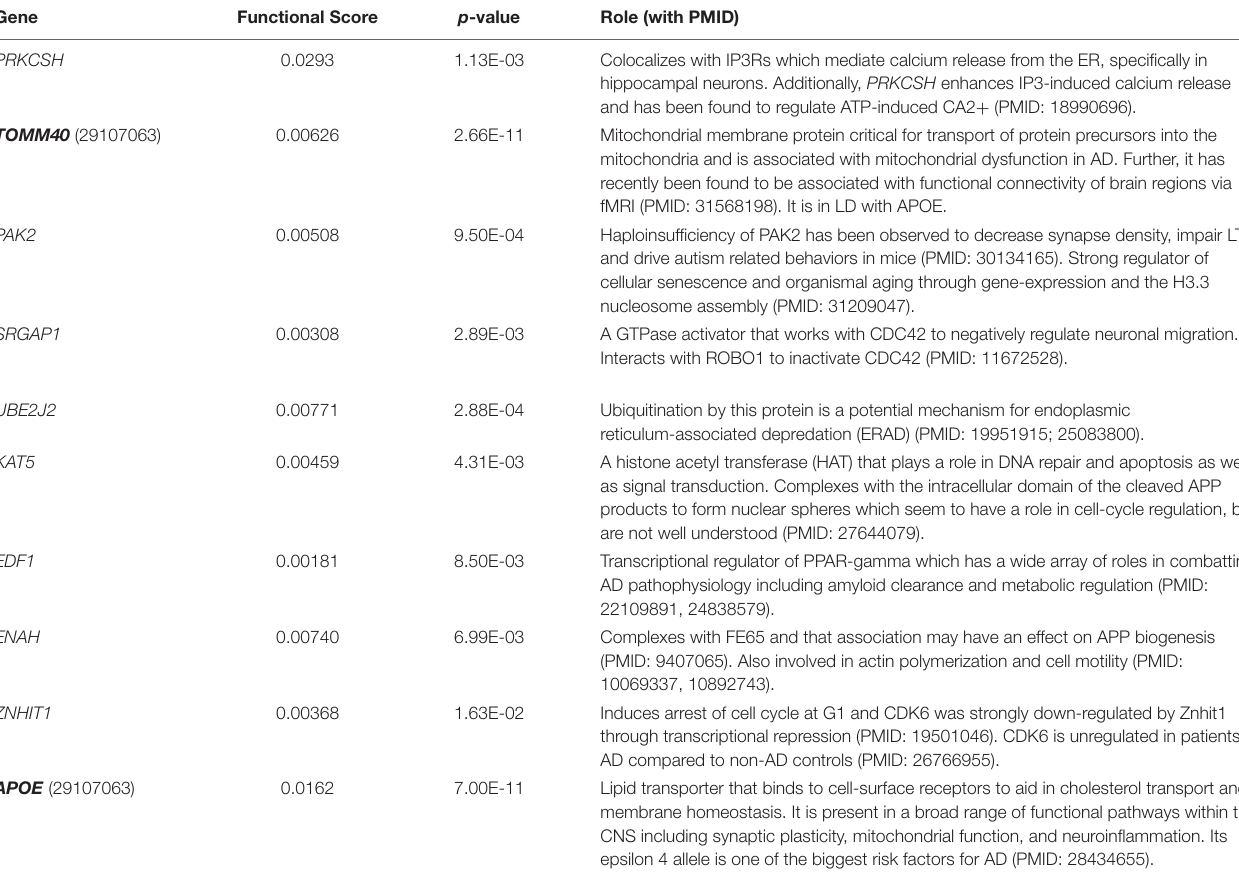
TABLE 2 | Brief descriptions of the top genes according to the combined score for the amygdala.